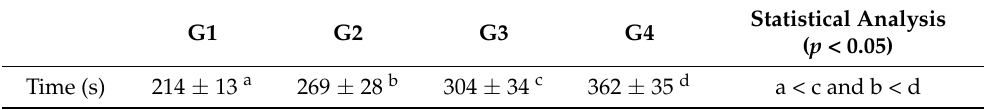
Table 1. Time required to re-establish the working length in the different groups. Different super- scripted letters (a–d) indicate significant differences between the different groups ( p < 0.05). Group 1 (G1): D-Race; Group 2 (G2): D-Race followed by the use of XP–Endo Finisher R; Group 3 (G3): Protaper Universal Retreatment; and Group 4 (G4): Protaper Universal Retreatment followed by the use of XP–Endo Finisher R. Statistical Analysis G1 G2 G3 G4 ( p < 0.05) Time (s) 214 ± 13 a 269 ± 28 b 304 ± 34 c 362 ± 35 d a < c and b < d